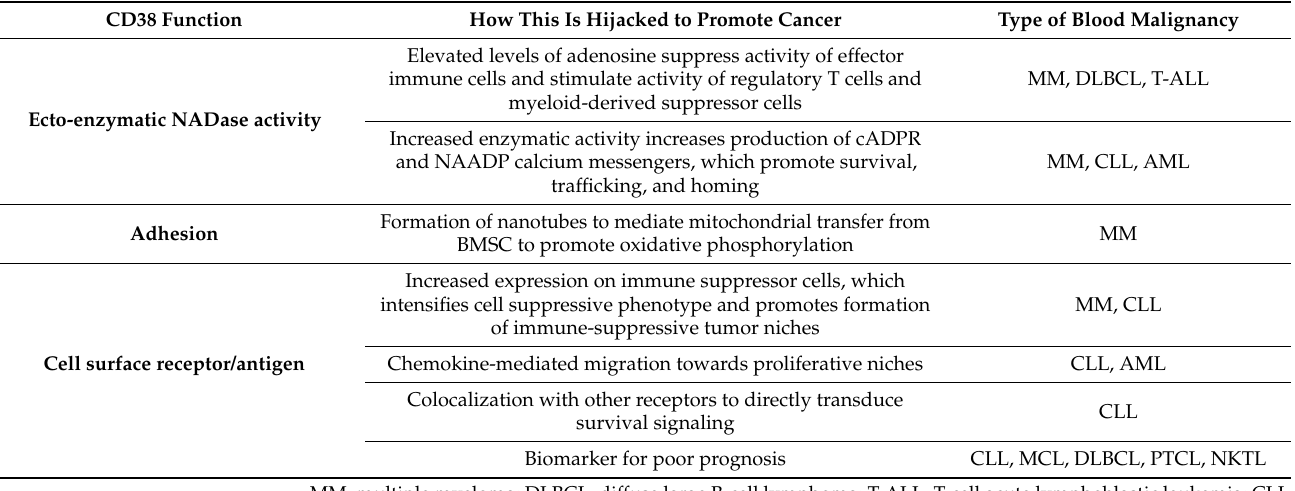
Table 1. Schematic overview of oncogenic mechanisms mediated by CD38 in different blood malignancies. CD38 Function How This Is Hijacked to Promote Cancer Type of Blood Malignancy